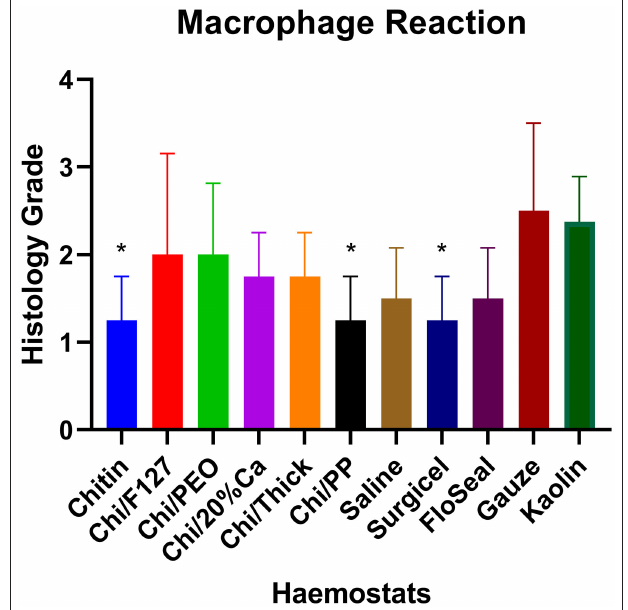
FIGURE 7 | Macrophage reaction seen with the application of modified and non-modified beta-chitin patches, Surgicel, FloSeal, Gauze and Kaolin (positive control) to rat brain. * p < 0.05 and compared to Gauze and Kaolin, analyzed by Kruskal-Wallis one-way ANOVA with Dunn’s test, n =